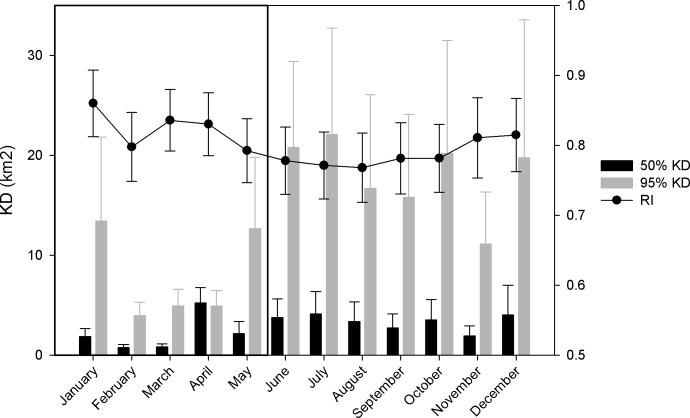
Monthly residency index and kernel density.(A) Monthly residency index (number of days detected divided by the number of days in each month) and (B) Monthly KD for transient, semi-transient, and resident female grey reef sharks tagged at Pohnpei and Ant Atoll, Micronesia during two tagging events in 2010 and 2012. The black box outlines aggregation months (January–May), while the shaded area represents months when either two or all three groupers are present (February–April).